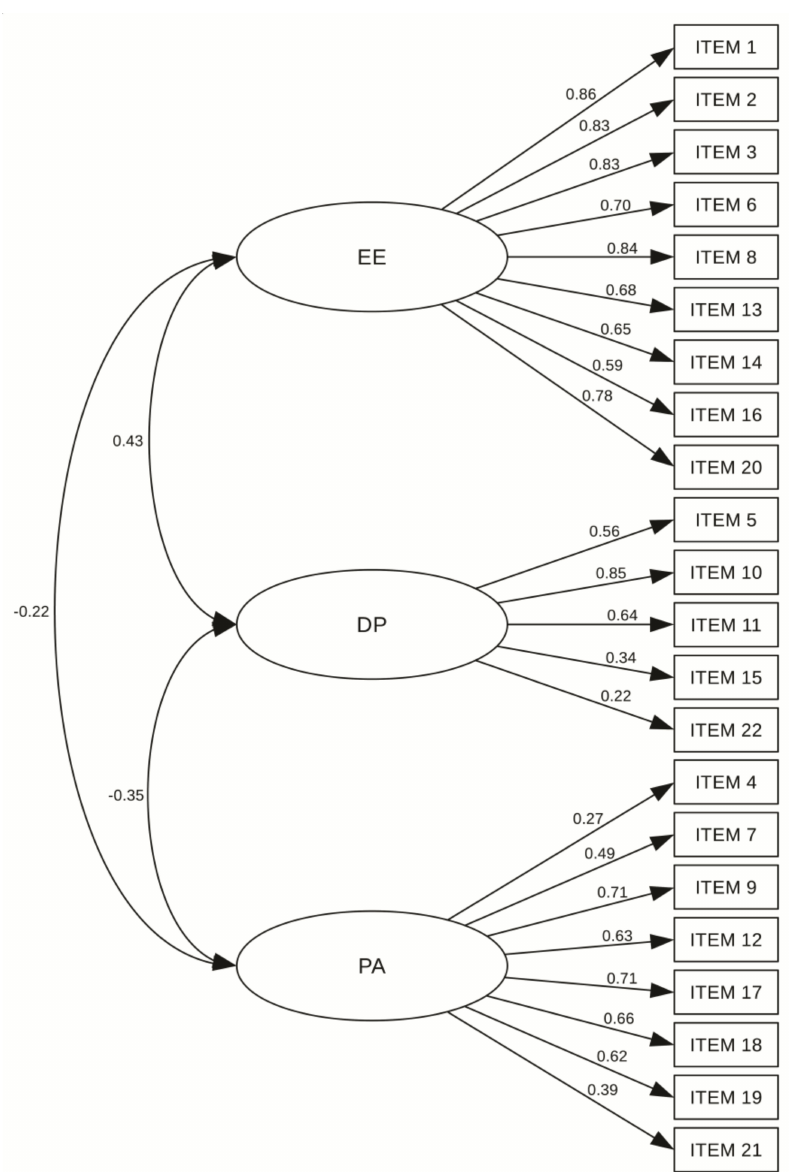
Figure 1. Standardized factor loadings for the Maslach Burnout Inventory—Educators Survey (MBI-ES) questionnaire in the Serbian language. EE, emotional exhaustion; DP, depersonalization; PA, personal